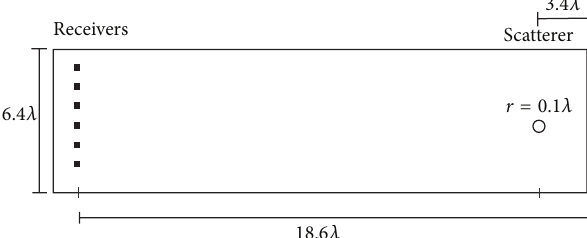
Figure 2: Scatterer detection in a waveguide of perfectly reflecting